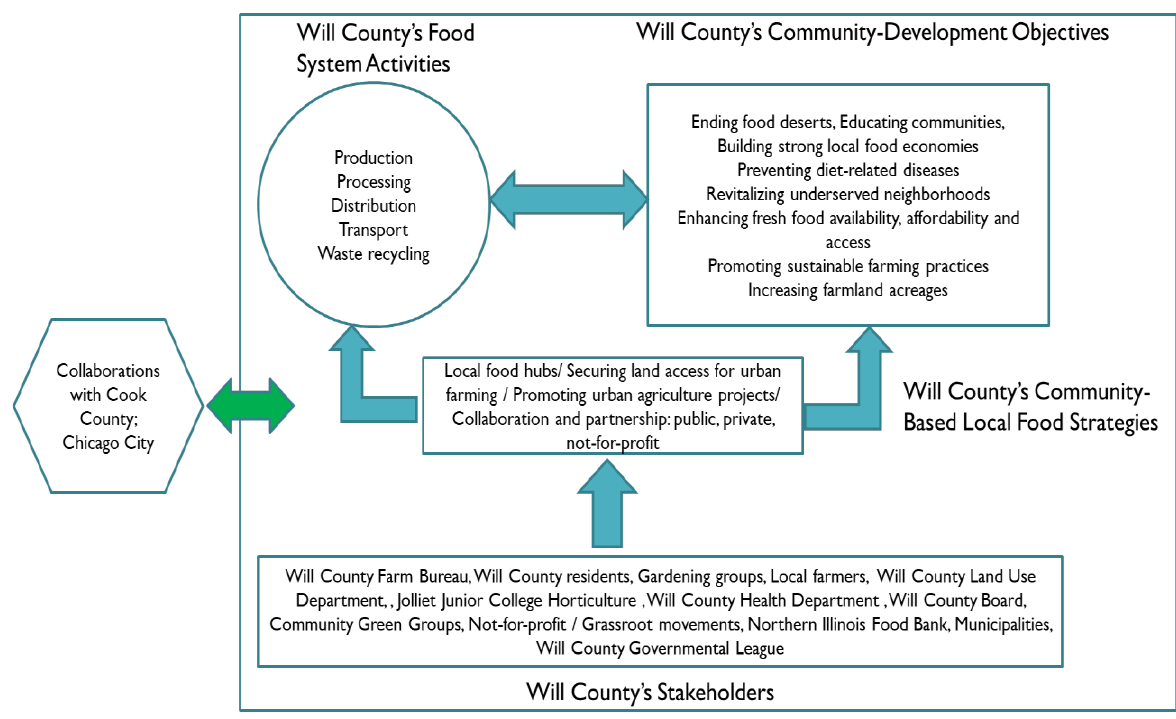
Figure 5. Will County’s Stakeholders and Food S ystem’s Community Development Objectives and